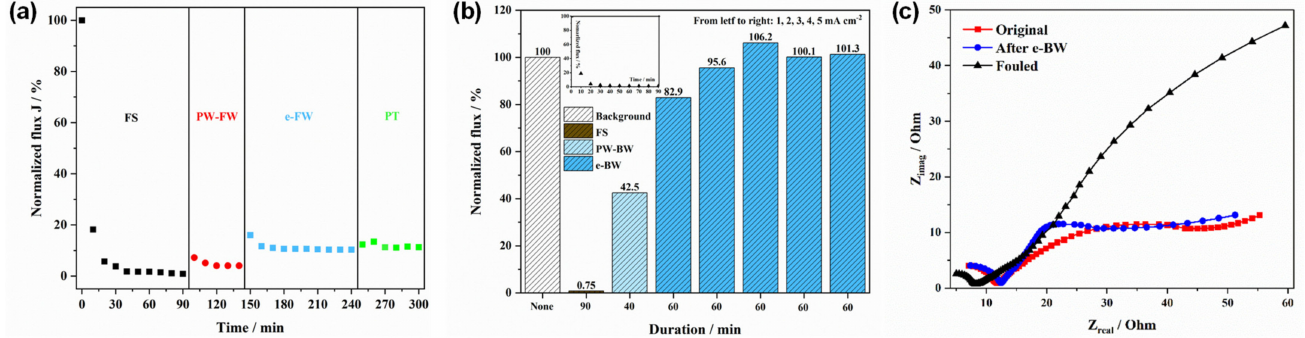
Figure 5. Normalized flux of PbO 2 -REM of the regeneration experiment in ( a ) FW mode, ( b ) BW mode, and ( c ) EIS spectra of original REM, the REM after electro-BW, and fouled REM in the complete frequency